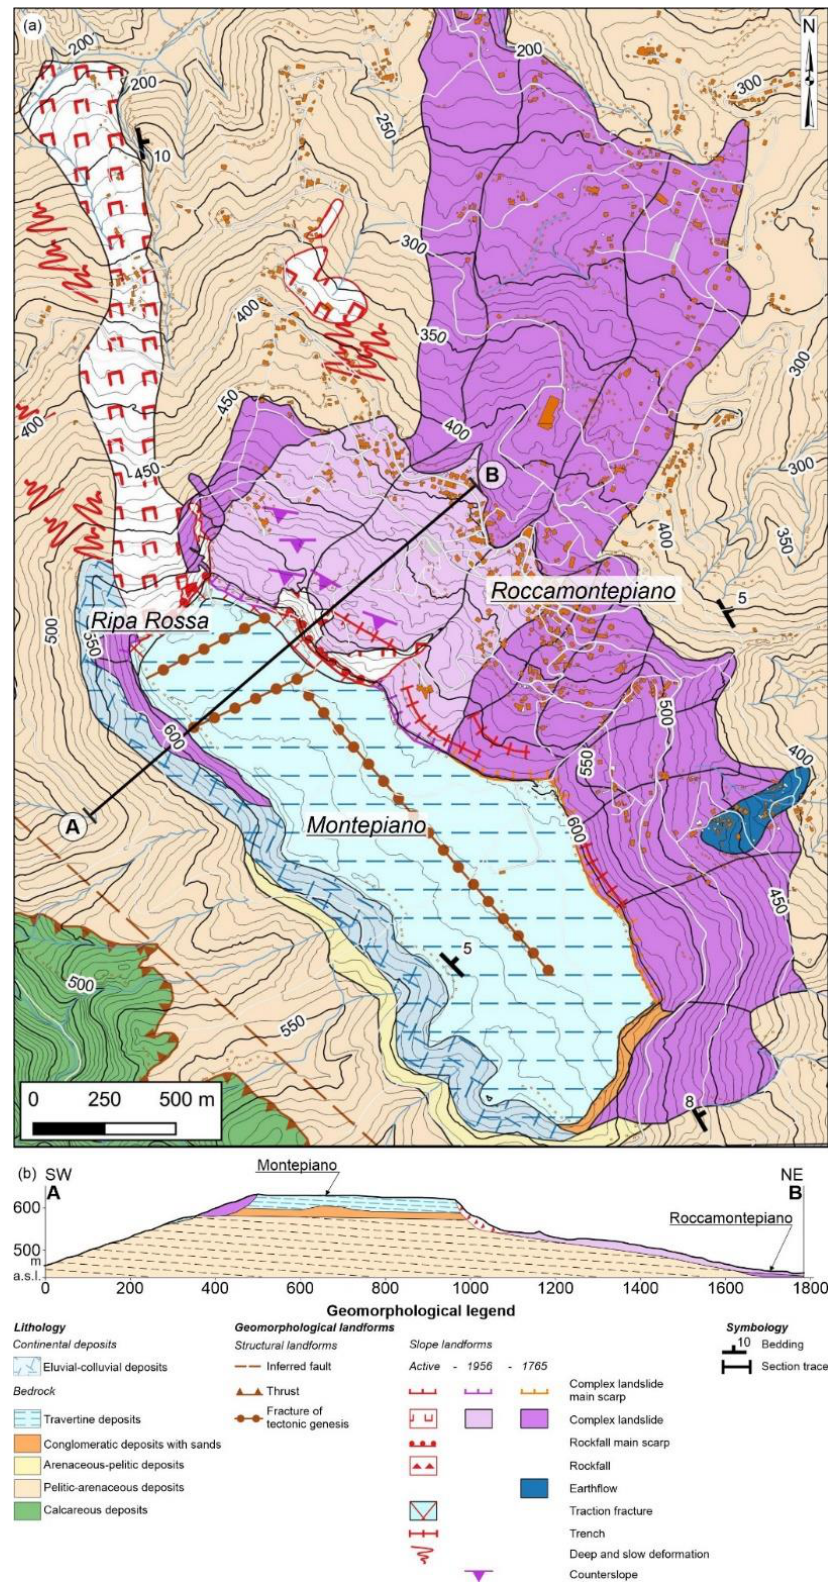
Figure 8. Roccamontepiano landslide: ( a ) multitemporal geomorphological map (derived from unpublished data and modified and updated from [82,83]); ( b ) geomorphological cross-section.